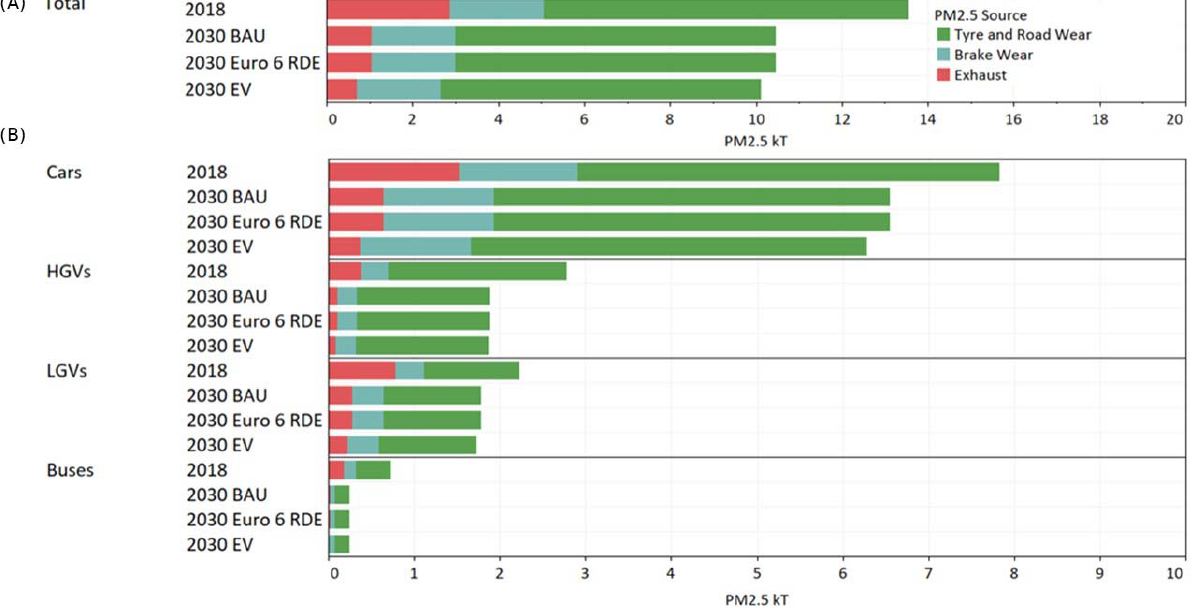
Figure 4. ( A ) Emissions of NOx from 2030 to 2050, where colour shows the emissions from each vehicle type. ( B ) PM2.5 Emissions from 2030 to 2050, where colour shows the emission source. In 2030 for all scenarios, NO x emissions are well below those observed in 2018. Both the Euro 6 RDE and EV scenarios reduce NO x beyond the BAU scenario, with emissions from diesel cars reducing the most for a single vehicle type in both scenarios. The yearly total NO x emissions for each scenario are illustrated in Figure 2 and are provided for each vehicle type and then further disaggregated by euro standard or technology in colour. In all the listed scenarios, emissions of PM 2.5 do not decrease by the same extent as NO x . Fleet emissions reduce by 3.1 kT from 13.6 kT in 2018 to 10.5 kT in 2030 BAU and only reduce by a further 0.3 kT for the EV scenario. PM 2.5 emissions for each scenario are given in Figure 3, which outlines emissions classified by vehicle type with the emissions further disaggregated by emission source: exhaust, brake wear, or tyre and road wear. Beyond 2030, for the EV scenario, NO x emissions are further reduced, most noticea ‐ bly between 2030 and 2040, and by 2050 NO x emissions are negligible. However, for PM 2.5 there is a much smaller relative reduction beyond 2030, with the exhaust emissions result ‐ ing in the reductions and non ‐ exhaust emissions remaining largely unchanged up to 2050. These results for NO x and PM 2.5 are illustrated in Figure 4.